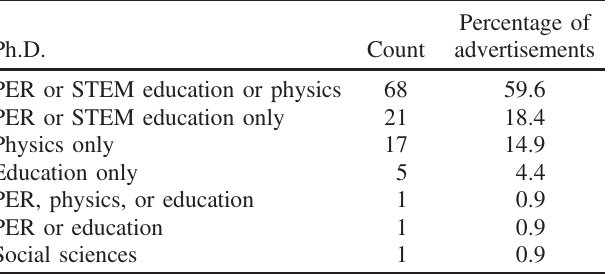
TABLE I. The doctoral education backgrounds prospective postdocs should have.